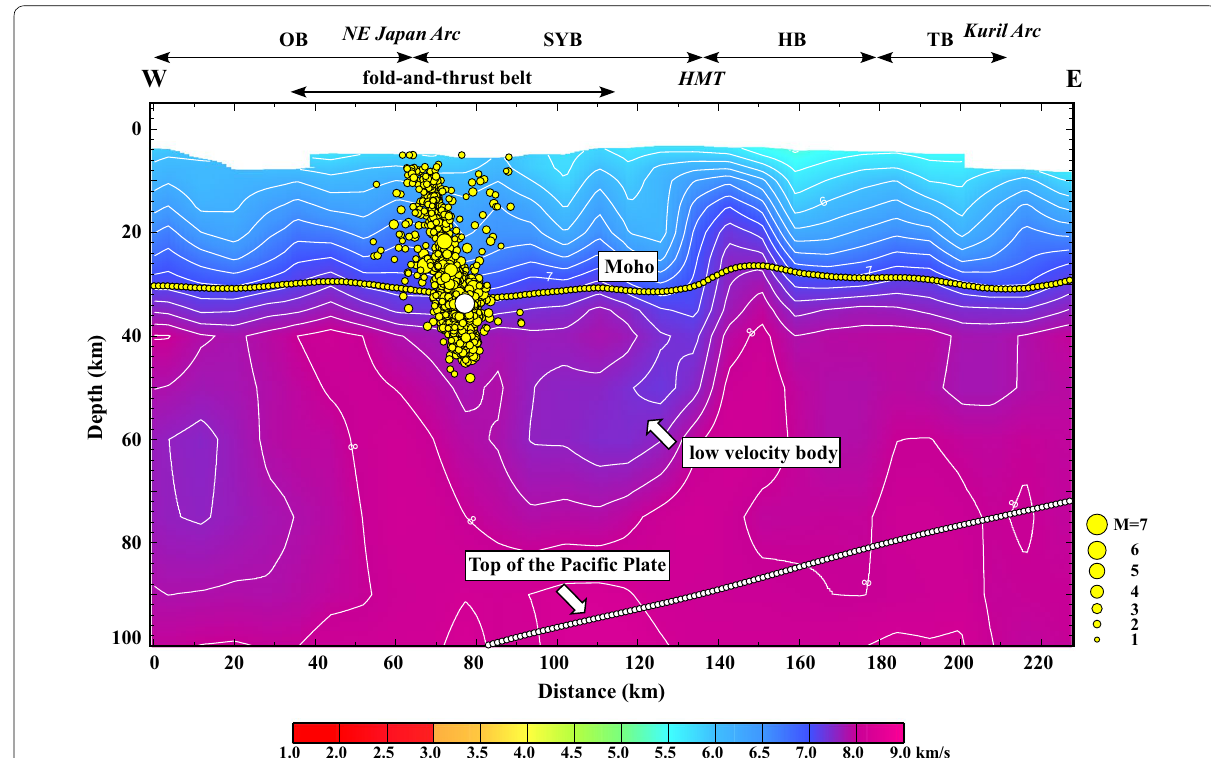
Fig. 11 Velocity structure from seismic tomography (Matsubara et al. 2017a) under the 1999 refraction/wide-angle reflection line of the Hokkaido Transect. All of the aftershocks relocated in the present study are shown by yellow circles. Projection line is the same as in the case of Fig. 9b. A large white circle is a hypocenter of the main shock determined by the present study. The Moho by Matsubara et al. (2017b) is shown by yellow circles. White circles show the top of the Pacific Plate by Iwasaki et al. (2015, 2016), which was mainly determined by hypocenter distribution of